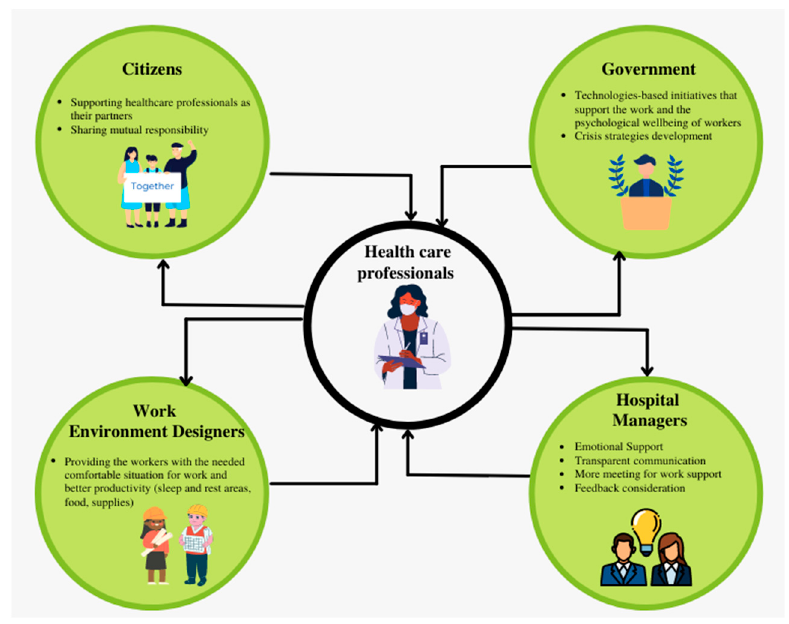
Figure 3. Crisis management recommendations to support healthcare professionals’ self ‐ control.